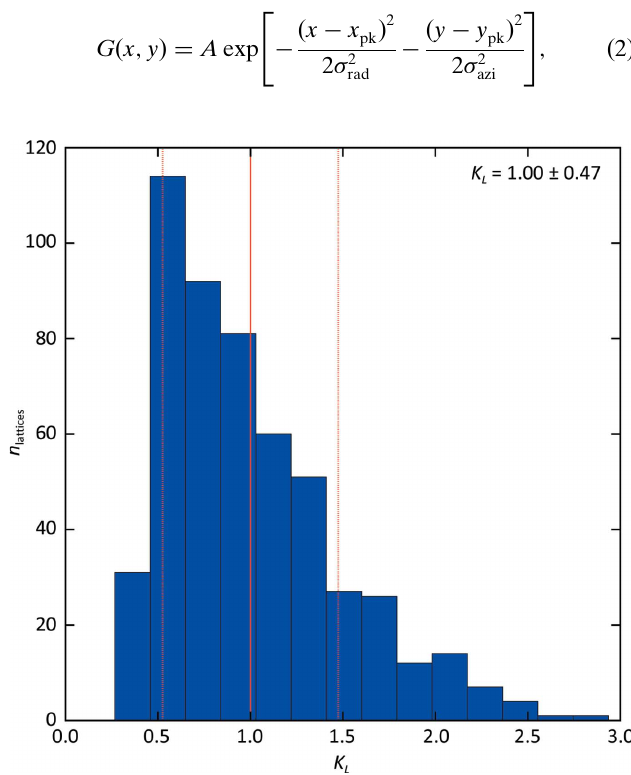
Figure 6 Scale factors. Histogram of the distribution of the lattice-dependent multiplicative scale factors K L calculated for 521 lattices and imposing an average value of